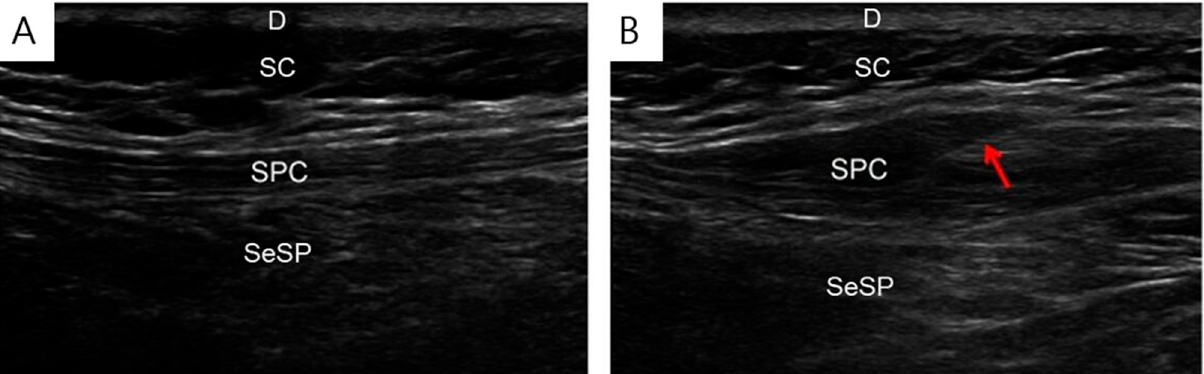
Figure 2. Isotonic saline injection under ultrasound guidance. Ultrasound images before ( A ) and during ( B ) the isotonic saline injection into the affected muscle. D, dermis; SC, subcutaneous; SPC, splenius capitis; SeSP, semispinalis capitis, needle (arrow).